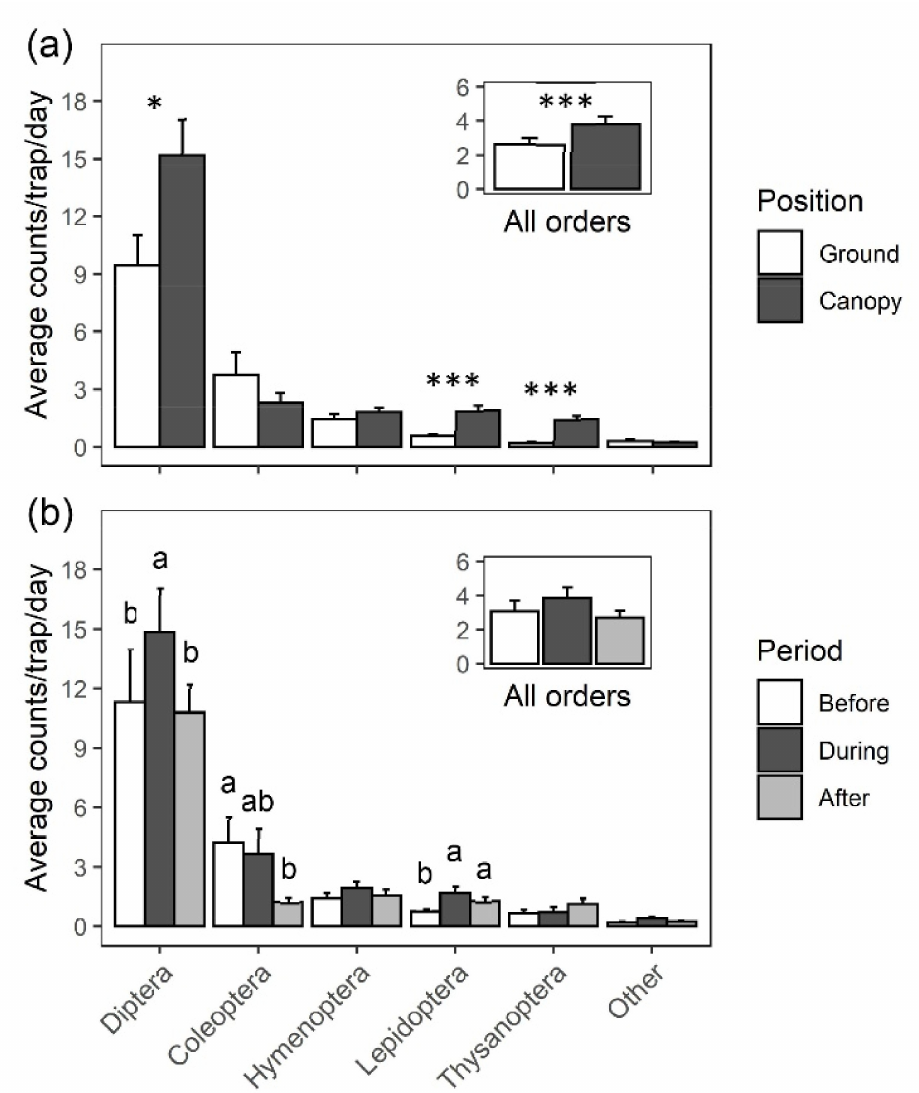
Figure 2. Captures of insects by orders in two trap locations (ground and canopy) and three trapping periods (before, during and after flowering): ( a ) main effect of trap position in doubly repeated measures ANOVA is indicated ( α = 0.05; *, p < 0.05; ***, p < 0.001); ( b ) different letters in each insect order indicate a significant difference in trap captures among flowering periods based on Tukey–Kramer test at α =